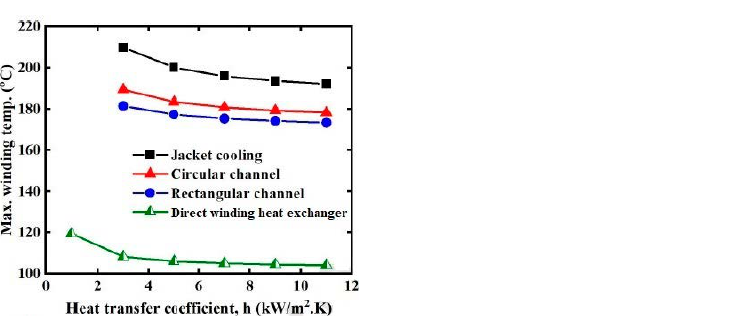
Figure 16. Comparing direct winding heat exchanger cooling with direct stator cooling [80].